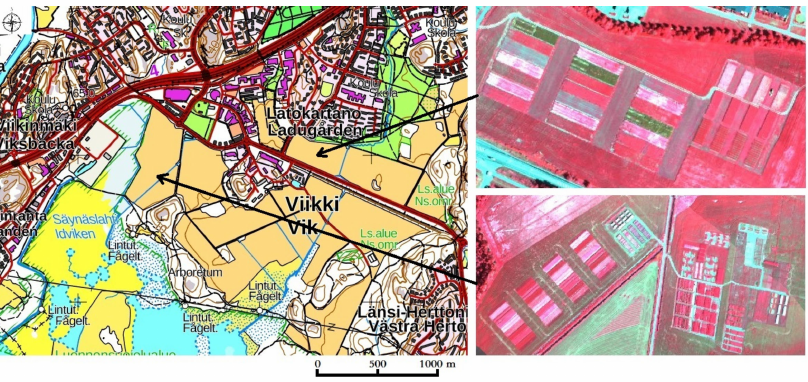
Figure 1. A map of the study site and airborne imagery of field